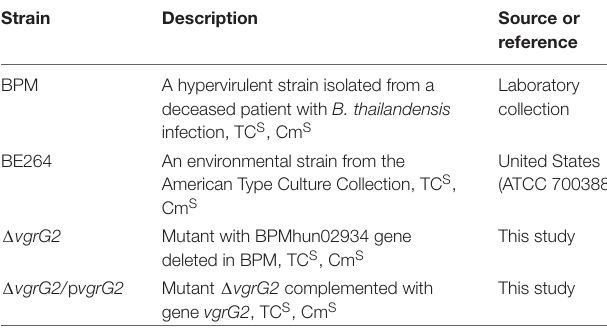
TABLE 1 | Bacterial strains used in this